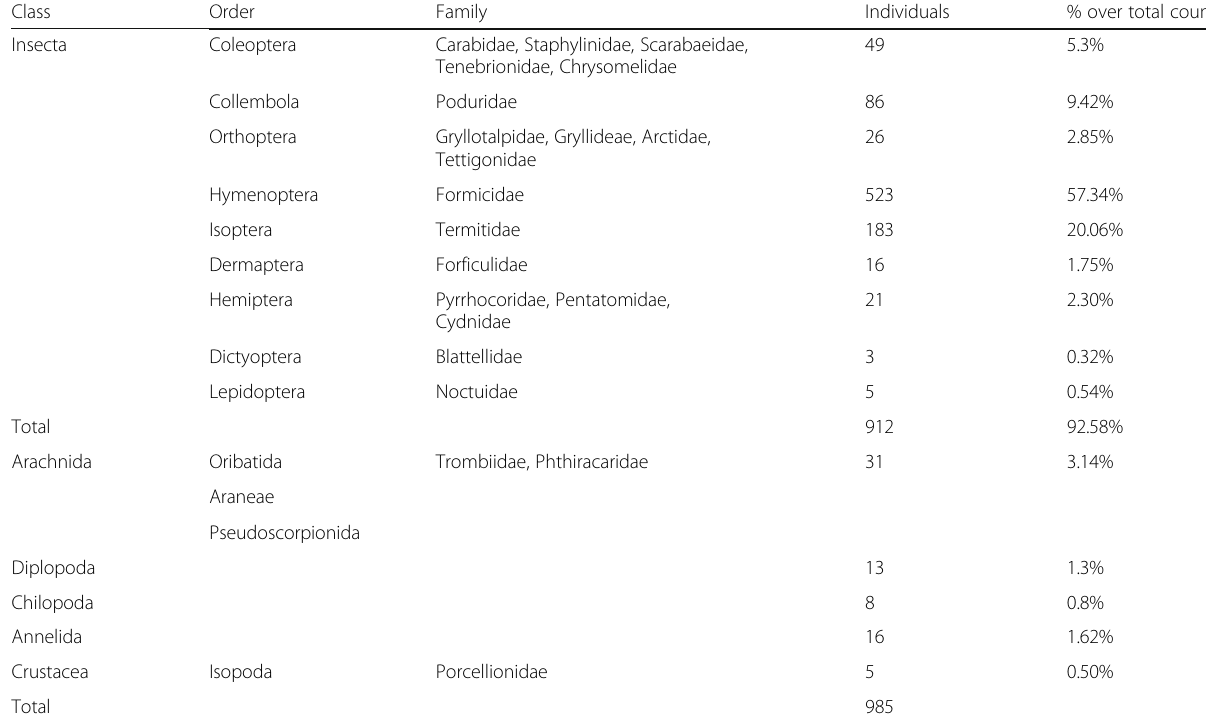
Table 1 Abundance of soil arthropods found in the experimental